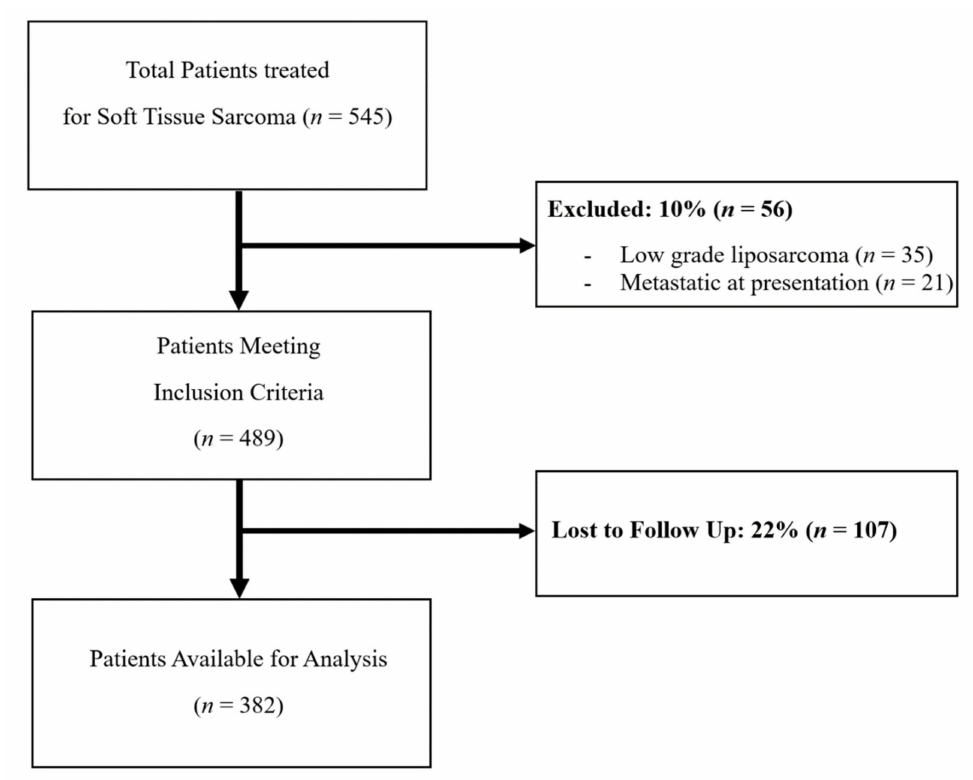
Figure 1. This STROBE flow chart demonstrates the inclusion of patients in this study. Table 1. Distribution of lost to follow up and included patients’ clinical and tumor